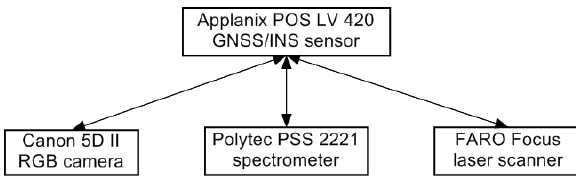
Figure 1. Sensor system used for road condition